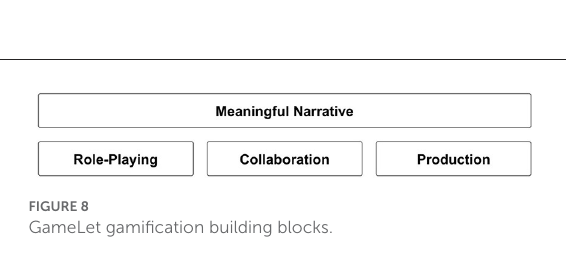
FIGURE8 GameLet gamification building